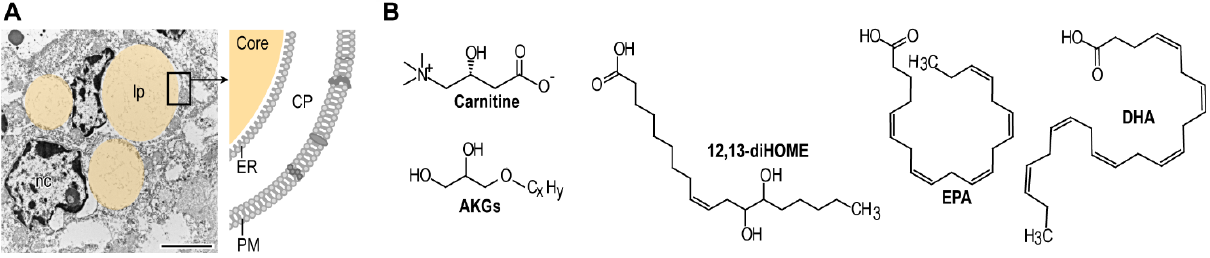
Figure 4. Breast milk lipids regulate fat metabolism. ( A ) Transmission electron microscopy image of a breast gland cell in lactating cattle. Lipid droplets are colored for better visibility. nc, nucleus; lp, lipid droplet (scale 2 µ m). The scheme shows the morphology of the milk lipid droplets: it contains a triglyceride core (Core), which is surrounded by a single membrane layer of endoplasmic reticulum (ER), the cytoplasm (CP) and the plasma membrane (PM) of the gland cell. All of these compartments are rich in lipid species, and bear hallmarks of the maternal lipid profile [13], and transmit lipid signals from mother to child. For instance, breast milk ether lipids are used for synthesis of inflammatory lipid mediators in the neonate [119], which is believed to increase pathogen defense. Excess secretion of inflammatory lipid species into the breast milk can cause inflammatory disease in mice [120], and is believed to increase the development of chronic inflam- matory diseases in human [40,121]. Breast milk lipid species are also responsible for proper adipose tissue development and functioning in the infant [12,19]. ( B ) Lipid species of breast milk that shape the development and function of adipo- cytes. AKGs, alkylglycerols; 12,13-diHOME, 12,13-dihydroxy-9Z- octadecenoic acid; EPA, eicosapentaenoic acid (ω -3 fatty acid); DHA, docosahexaenoic acid (ω -3 fatty acid). Breast milk of mothers with overweight and obesity have higher ω -6 PUFAs levels and lower ω -3 PUFAs levels than the breast milk of normal-weight mothers [122], and it has been shown that the ratio of ω -6 relative to ω -3 ( ω -6/ ω -3) fatty acids in human breast milk has increased three-fold over the last 30 years [123]. Dietary intake of ω -3 PUFAs increases thermogenic fat development in adulthood [124,125], and an increased ω -6/ ω -3 ratio of fatty acids in the colostrum is associated with increased adiposity in the first 6 months of life [122]. However, breast milk ω -3 PUFAs (unlike colostrum ω -3 PUFAs) do not affect [126] or may even increase fat mass in the first year of life [127], probably due to the fact that ω -3 PUFAs may be used for de novo lipid synthesis instead of fatty acid oxidation [128]. PUFAs hence may have distinct effects immediately after birth (when co- lostrum is consumed and a rapid lipolysis appears) and later in infancy (when breast milk is consumed and lipogenesis is ongoing). PUFAs can be metabolized into lipid mediators, or can act through free fatty acid receptor 4 (FFAR4, also termed GPR120).GPR120 defi- ciency causes obesity in mouse and human, due to increased adipocyte differentiation and